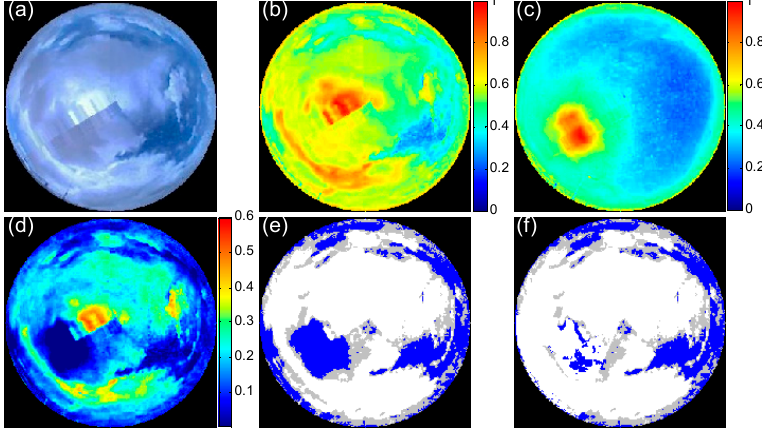
Figure 5. Probability distribution of three types of pixel RBR difference on sample images.